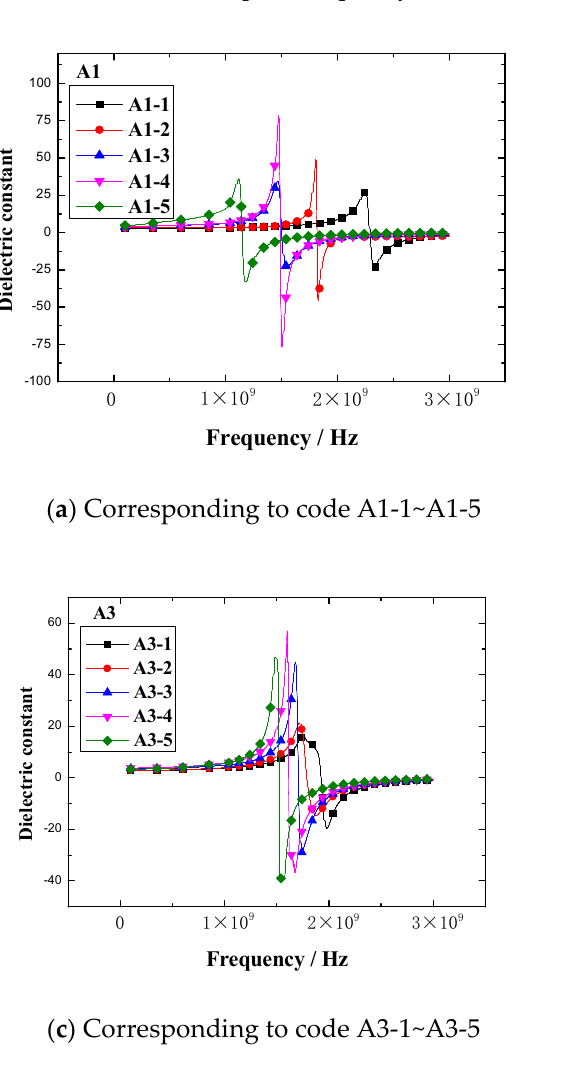
The peak frequency(GHz) The peak of dielectric constant